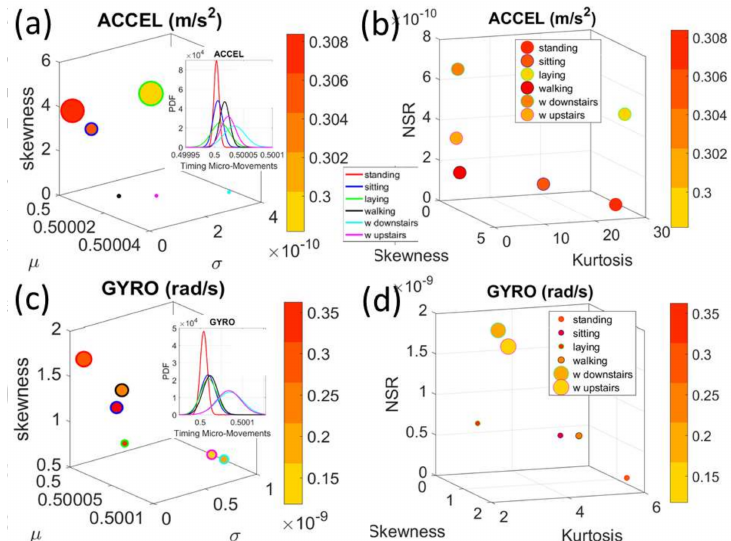
Figure 8. Comparison of acceleration and gyro signatures for the summary (group) data set involving the mean values of fluctuations in peak-timing. ( a ) Separation into two general types of activities (see legend and marker edge color). ( b ) Gamma skewness, kurtosis and NSR also distinguish across activities. ( c , d ) Gyro’s angular speed peak-timing related signatures distinguish between the overt and covert-movement related activities.